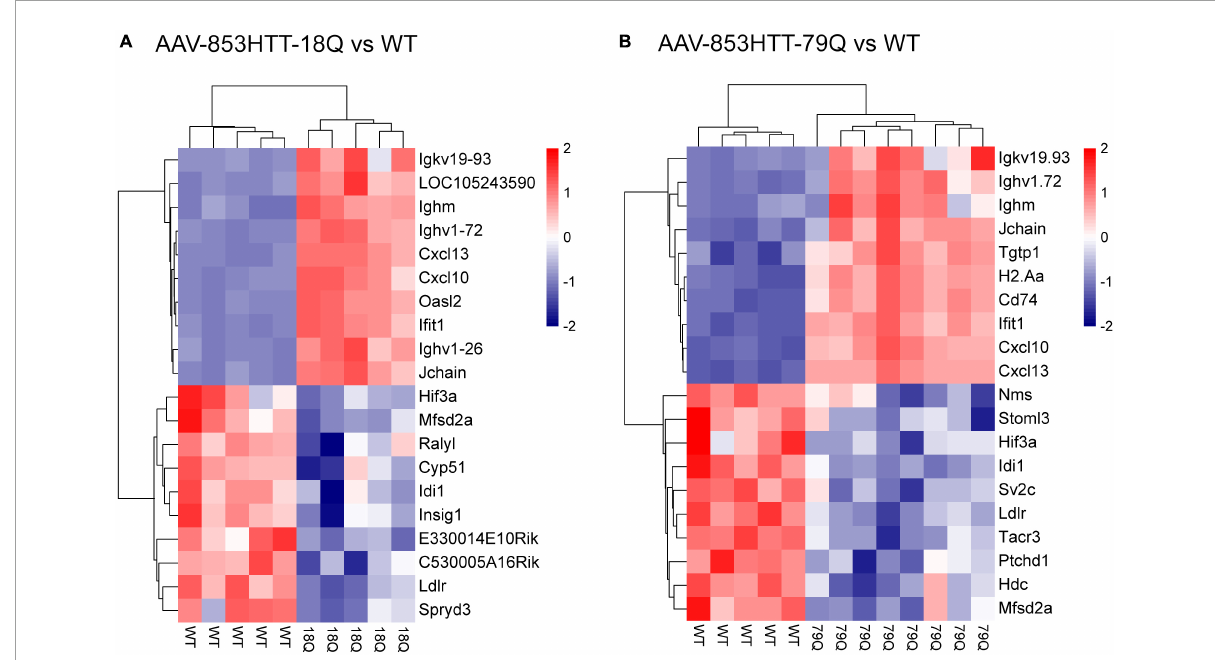
FIGURE3 Top-ranked downregulated genes in the 79Q vs. wild type (WT) dataset include histidine decarboxylase ( Hdc ), tachykinin receptor 3 ( Tacr3 ), and neuromedin S ( Nms ). Heatmap of scaled RMA-limma values [scale(rows)] with hierarchical clustering showing the top 10 up- and top 10 downregulated genes, based on adj. p and log2(FC) in (A) 18Q vs. WT and (B) 79Q vs. WT. Hdc , Tacr, Nms, and Sv2c, associated with neuroendocrine signaling, were significantly altered (criteria adj. p < 0.05) in the 79Q vs. WT limma dataset. 79Q, HTT853-79Q vector; 18Q, HTT853-18Q vector; Sv2c, synaptic vesicle glycoprotein